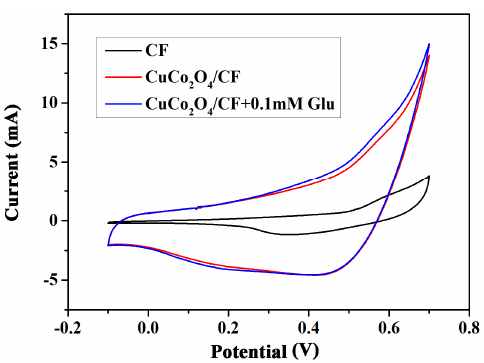
Figure 5. CV curves of bare Cu foam (black line) and CuCo 2 O 4 nanosheets in the absence (red line) and presence (blue line) of 0.1 mM glucose in 0.1 M NaOH at 50 mV·s −1 .